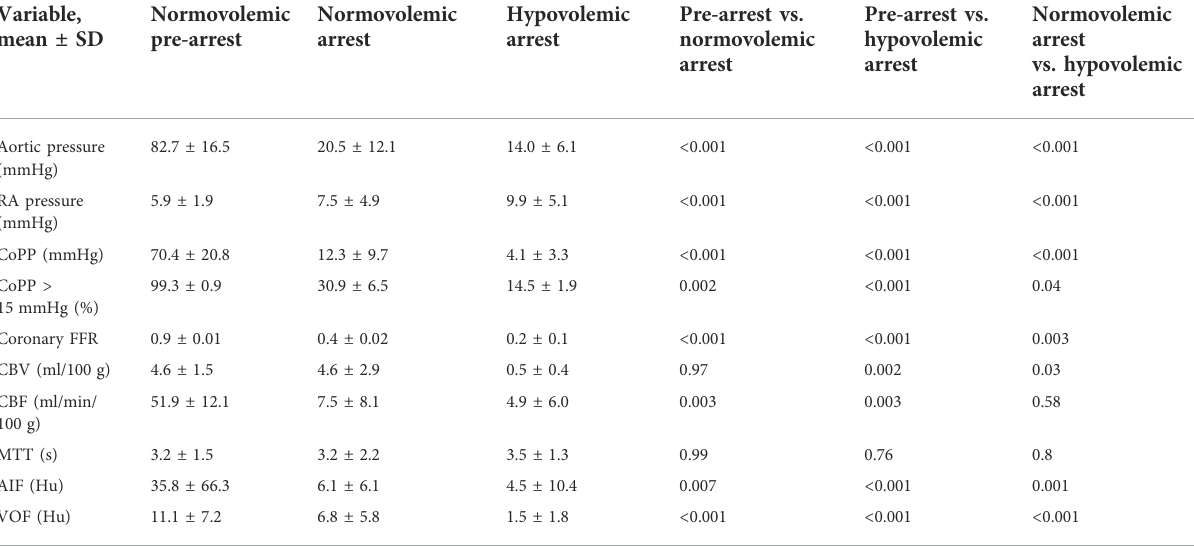
TABLE 2 Hemodynamic characteristics of normovolemic arrest and hypovolemic arrest during open cardiac massage. Variable, mean ± SD